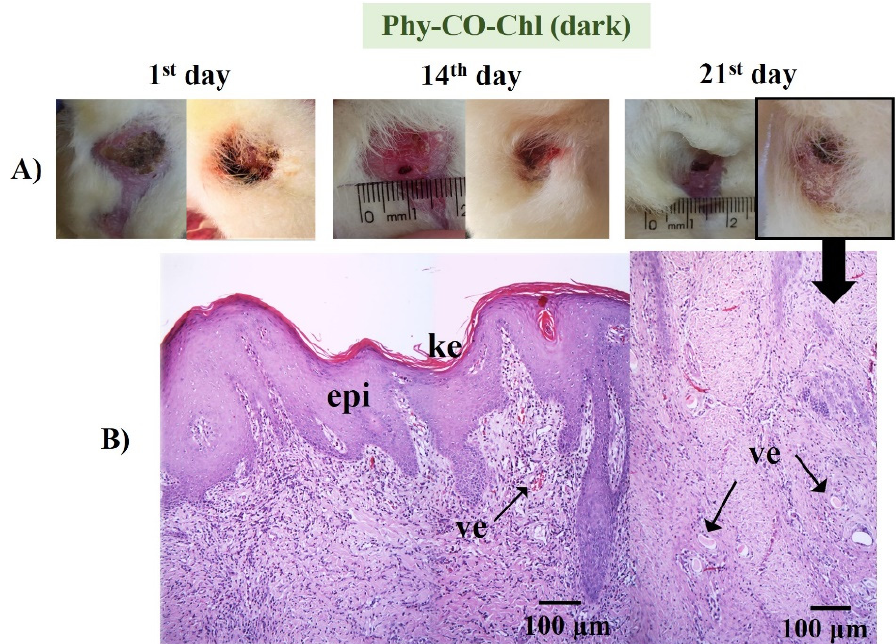
Figure 13. ( A ) Macroscopical aspects of the plantar face of feet in rabbits during the Phy-CO-Chl treatment, without PDT use. The arrow in the photo of the feet indicates that the paw was analyzed histologically. ( B ) Histological aspect of skin in the last day of treatment (paraffin section, HE). The images show the keratin layer (ke) and the presence of tissue vascularization (ve).